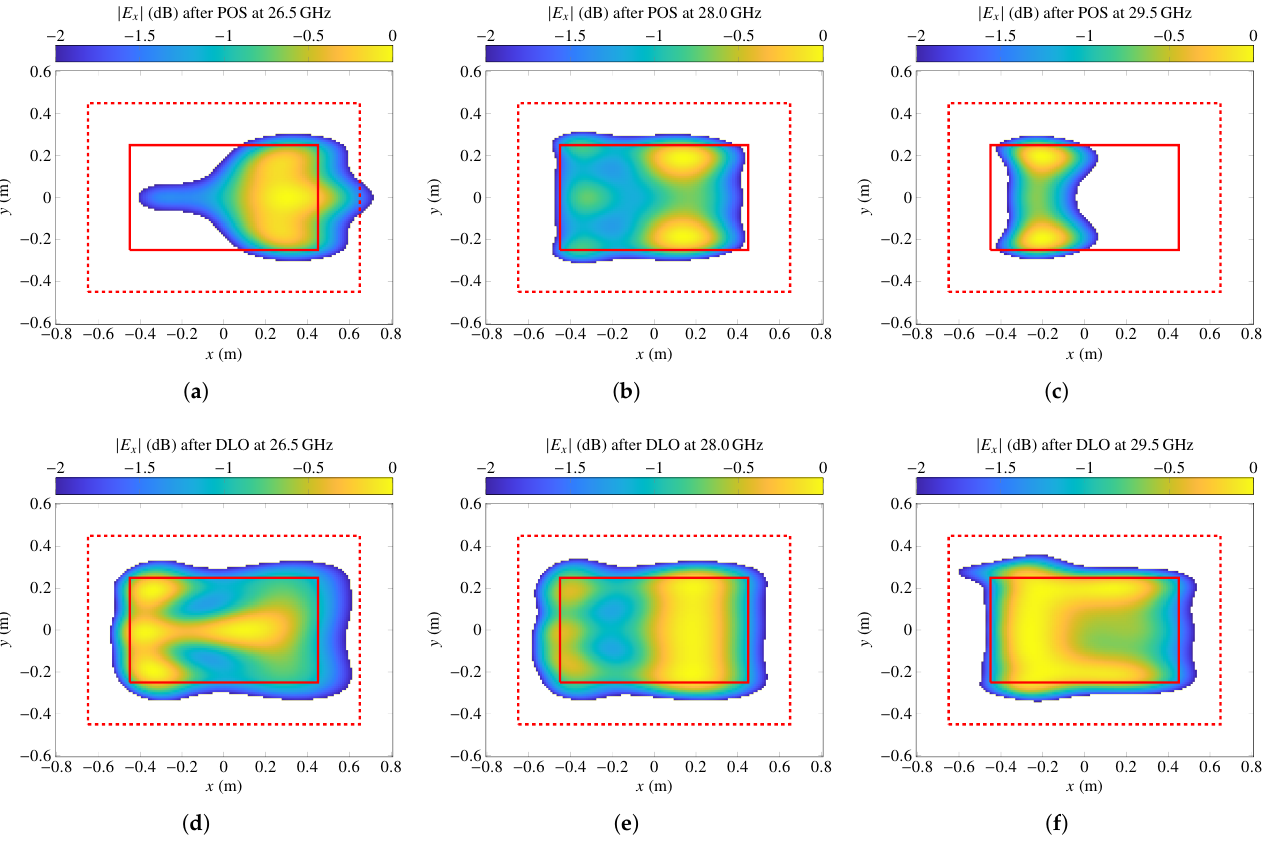
Figure 9. Representation of the normalized electric field magnitude for linear polarization X that complies with a ripple of 2dB at 26.5GHz ( left column), 28GHz ( middle column), and 29.5GHz ( right column) generated by the layout obtained after the POS ( top row) and after the direct layout optimization (DLO) with the GIA ( bottom row). Coverage zone is represented by a solid red line and transition zone by a dashed red line. Near field is plotted in the NFCS. Table 4 gathers the performance of the optimized layout at seven equispaced